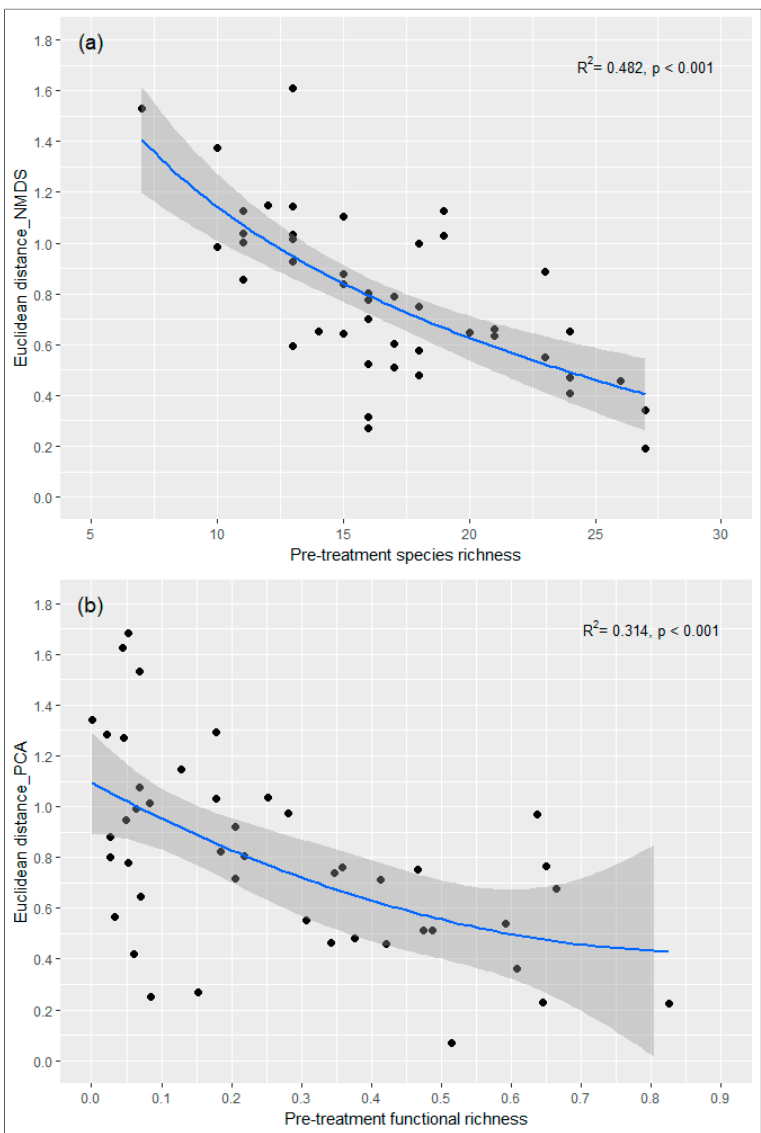
Figure 7. Relationship between ( a ) pre-treatment species richness and changes in species composition from pre- to post-disturbance communities; ( b ) pre-treatment functional richness and shifts in functional composition, based on four traits (height, seed mass, SLA, LDMC). Changes in floristic and functional composition were quantified by vector length in NMDS ( a ) and principal component analysis (PCA) ( b ) ordination space, respectively. For this analysis, data from 45 plots in canopy gaps (100% cut) were used, as they showed the most prominent changes after the cutting. Significant logarithmic ( a ) and second-order polynomial ( b ) regression lines (in blue) with corresponding 95% confidence envelopes are